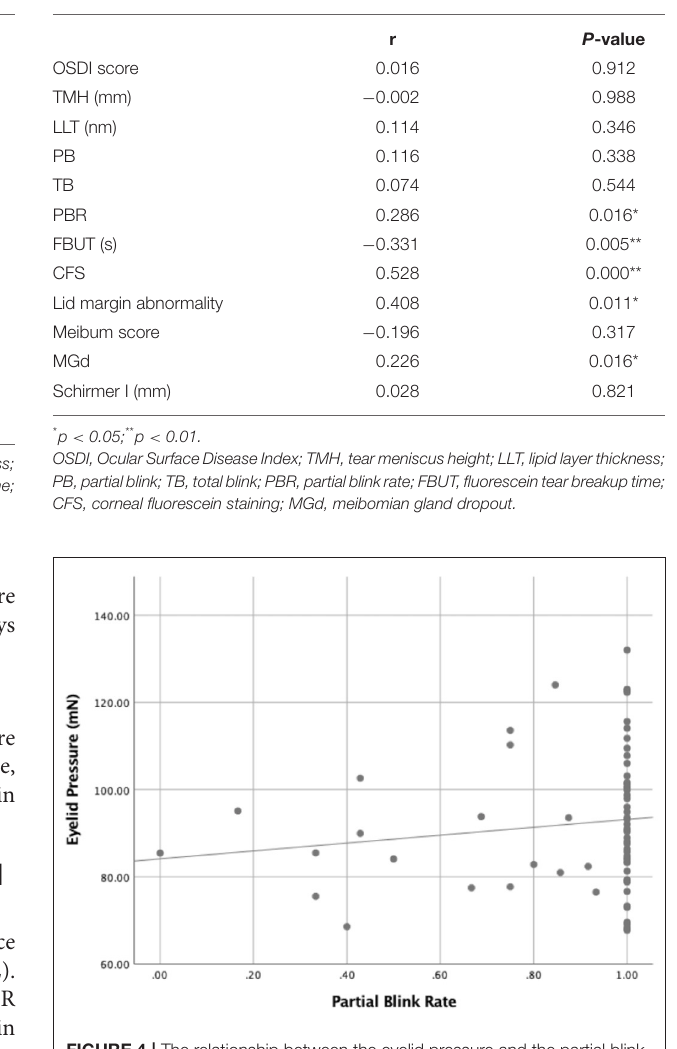
TABLE 1 | Descriptive statistics of 35 moderate-to-severe DED patients. Parameters